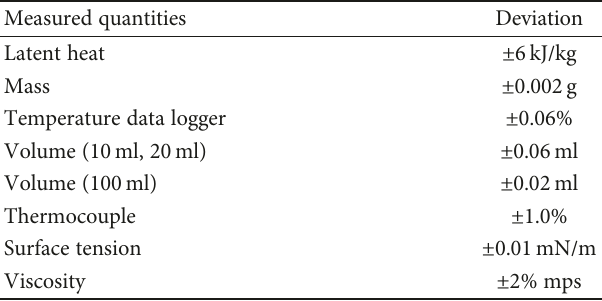
Figure 1: Nanocomposite PCM preparation fl ow chart. Table 2: Result uncertainty analysis of experimental